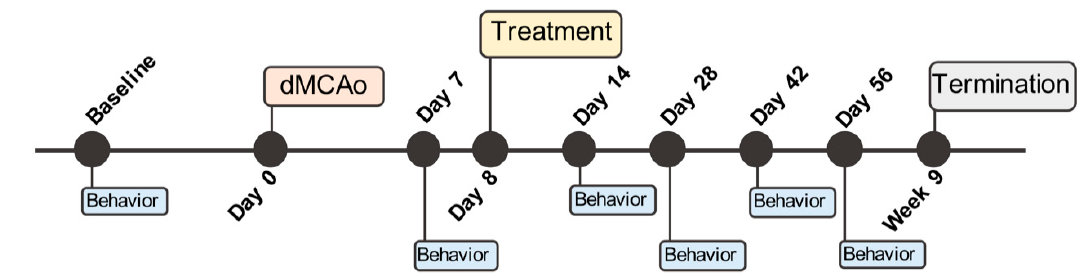
Figure 7. Experimental timeline of procedures, treatment administration, and behavioral testing.